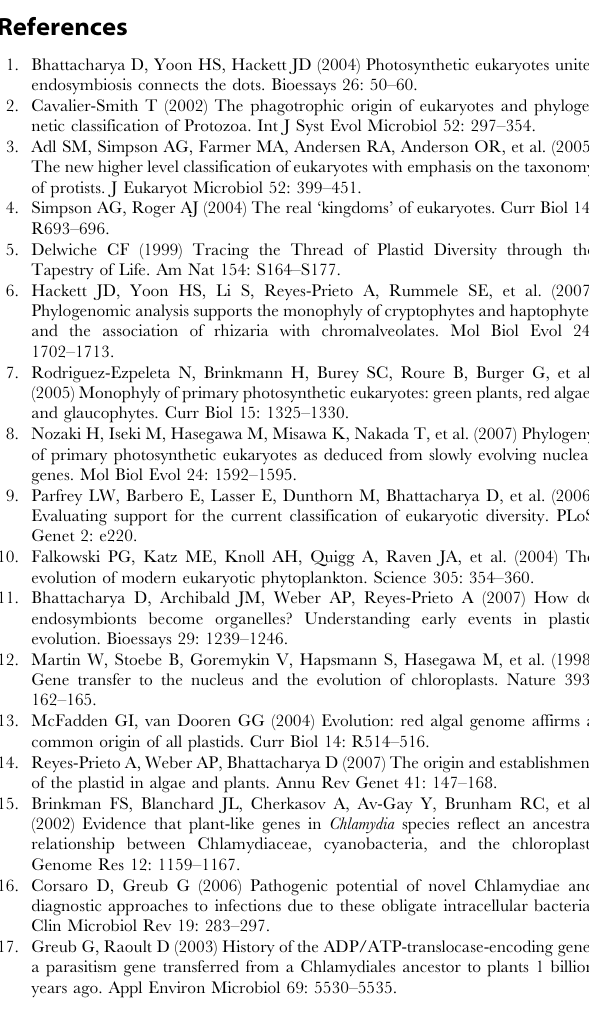
Table S3 Complete set of taxa present in our local genome database that was used to search for chlamydial genes in